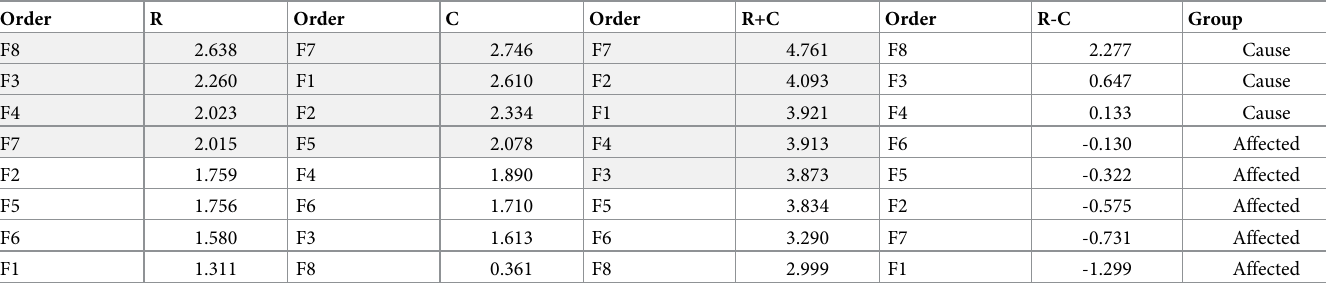
Table 5. Total effects and net effects for factor.